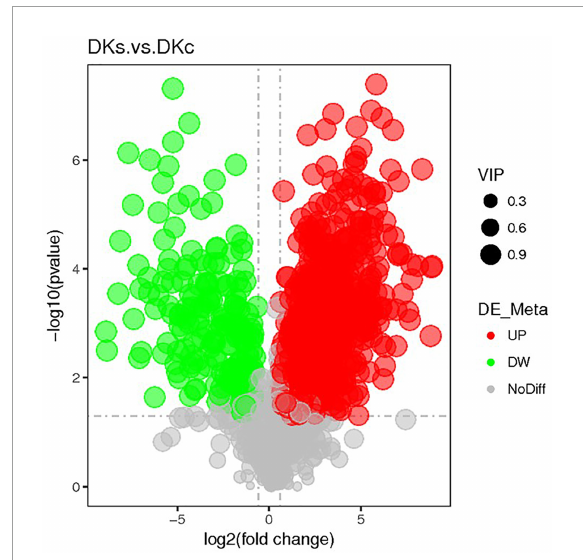
FIGURE3 The PLS-DA. The abscissa is the score of the sample on the first principal component; the ordinate is the score of the sample on the second principal component; R2Y represents the interpretation rate of the model, and Q2Y is used to evaluate the predictive ability of the PLS-DA model, and when R2Y is greater than Q2Y Indicates that the model is well established.